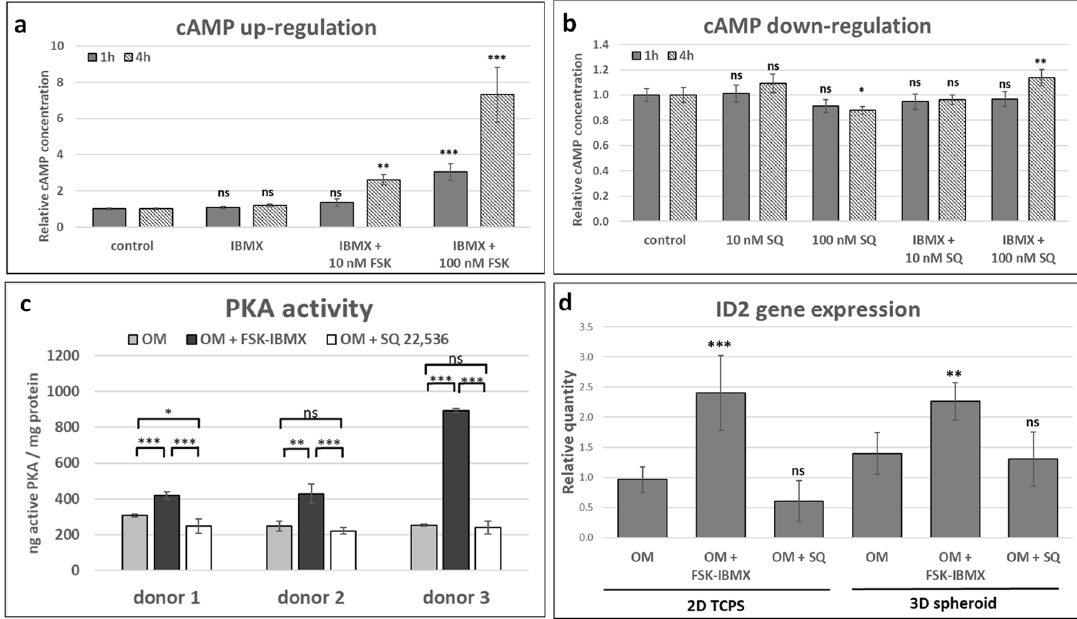
Figure 2. E ff ect of adenylate cyclase regulation on cAMP pathway activity. Cells cultured in OM and treated with adenylate cyclase activator forskolin (FSK, concentration of 10 nM unless indicated otherwise) and phosphodiesterase inhibitor 3-isobutyl-1-methylxanthine (IBMX, 500 nM), or with adenylate cyclase inhibitor SQ 22,536 (100 nM unless indicated otherwise). Analysis of intracellular cAMP under cAMP ( a ) upregulation and ( b ) downregulation. Cells in suspension treated with regulator for 1 or 4 h, and each treated sample contained 5000 cells. Relative cAMP concentration, normalized to control sample, is shown. ( a , b ) Mean from three experiments performed on cells isolated from a single donor, error bars represent standard deviation. ( c ) protein kinase A (PKA) activity assay. Cells cultured with regulators for 48 h. PKA activity shown as ng of active PKA enzyme, normalized to the amount of total protein in sample. Mean from three experiments performed on cells isolated from di ff erent donors; results from each cell donor separately presented, error bars represent standard deviation. ( d ) Relative expression of ID2 gene, cyclic–AMP response element binding protein (CREB) target gene. Cells cultured with regulators for 48 h. Mean from three experiments performed on cells isolated from di ff erent donors. Control, undi ff erentiated cells; “0”, cells cultured in OM without regulators. Error bars, ± 95% confidence interval. Statistical significance between control or OM and adenylate cyclase regulation conditions is marked: *, p < 0.05; **, p < 0.01; ***, p < 0.001; ns, not significant.